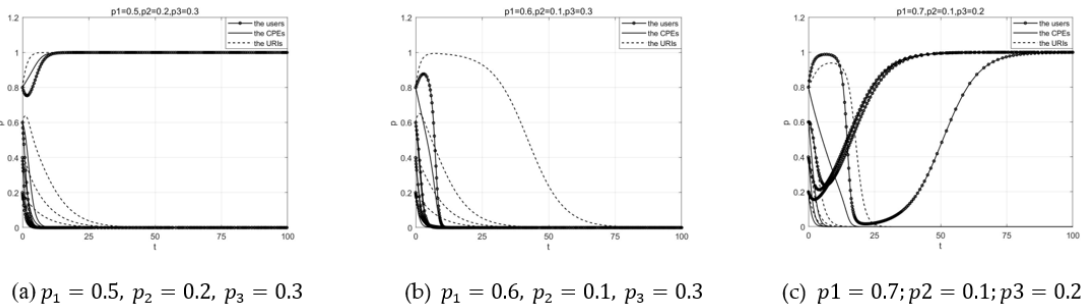
Figure 5. Impact of risk-taking ratio on the strategies of the Users, the CPEs and the URIs, and ( a – c ) show the evolution of the tripartite strategies under different values of p 1 , p 2 , p 3